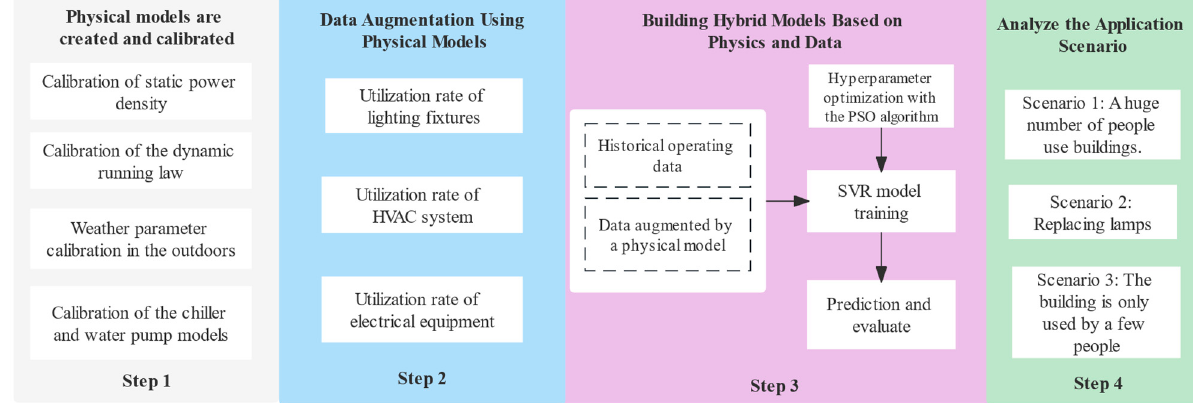
Figure 1. A framework for data augmentation.